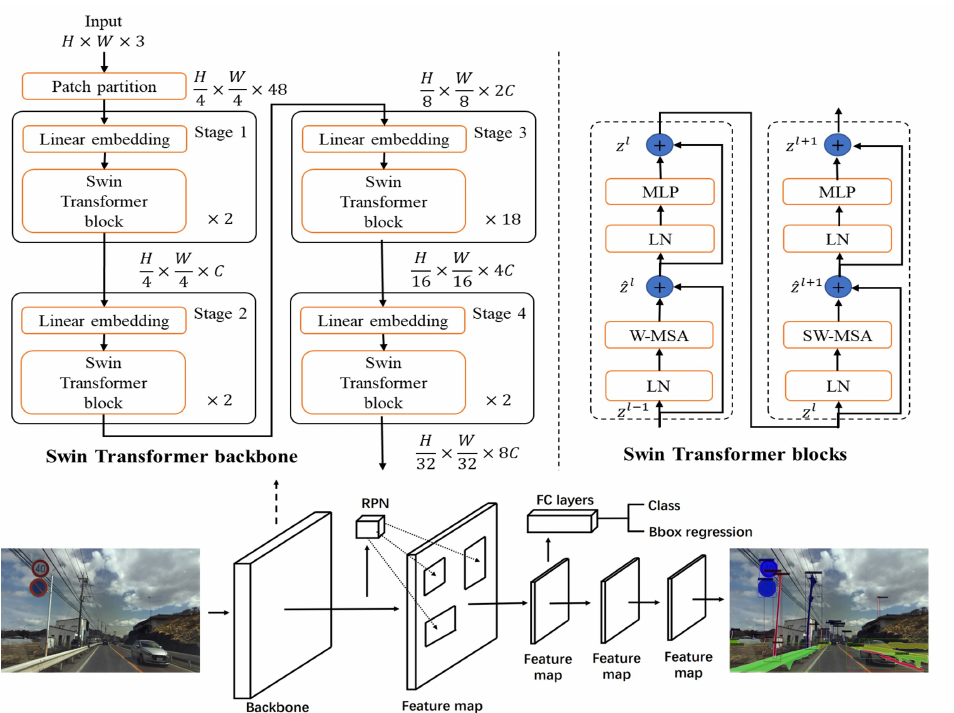
Figure 2. Architecture of Mask R-CNN with Swin